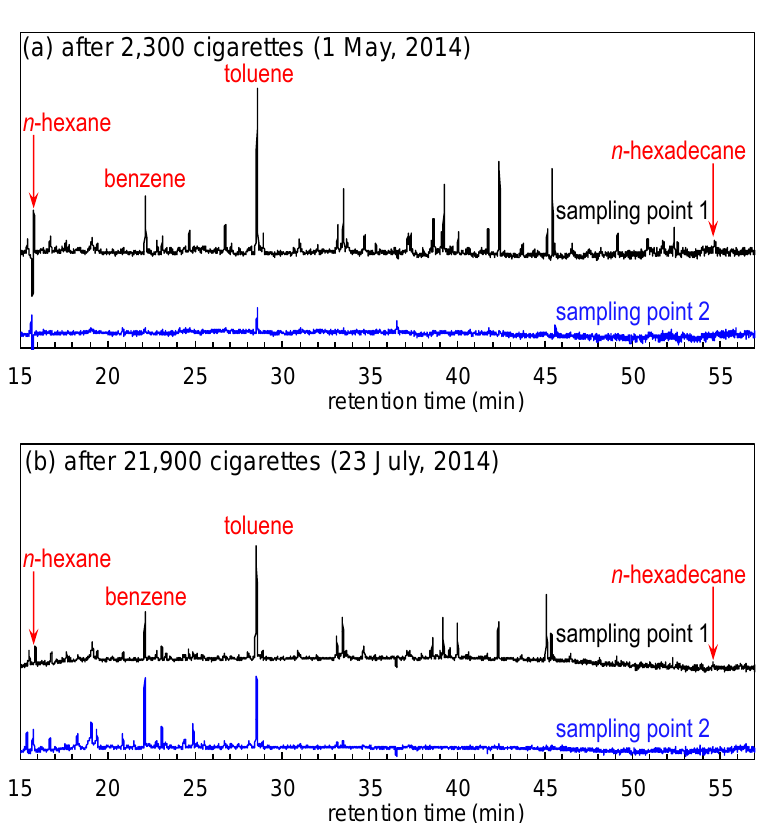
Figure 6. Normalised GC-MS chromatograms of the air samples from the Figure 2 sampling points 1 (black) and 2 (blue) after the treatment of ( a ) 2300 and ( b ) 21,900 cigarettes-worth of tobacco